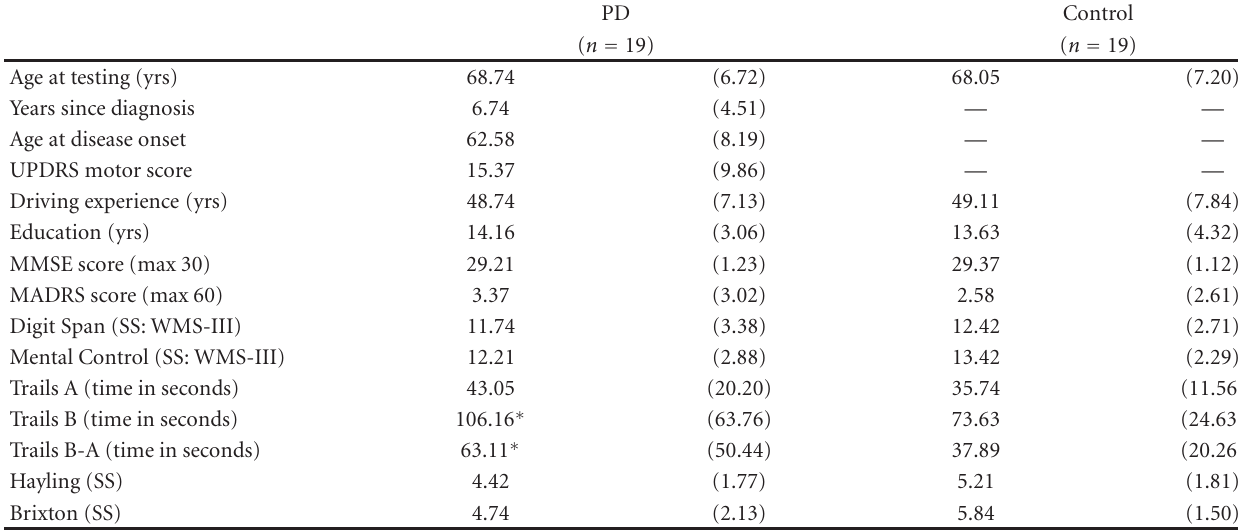
Table 1: Means (and SDs) of demographic and neurocognitive information for PD and control groups.